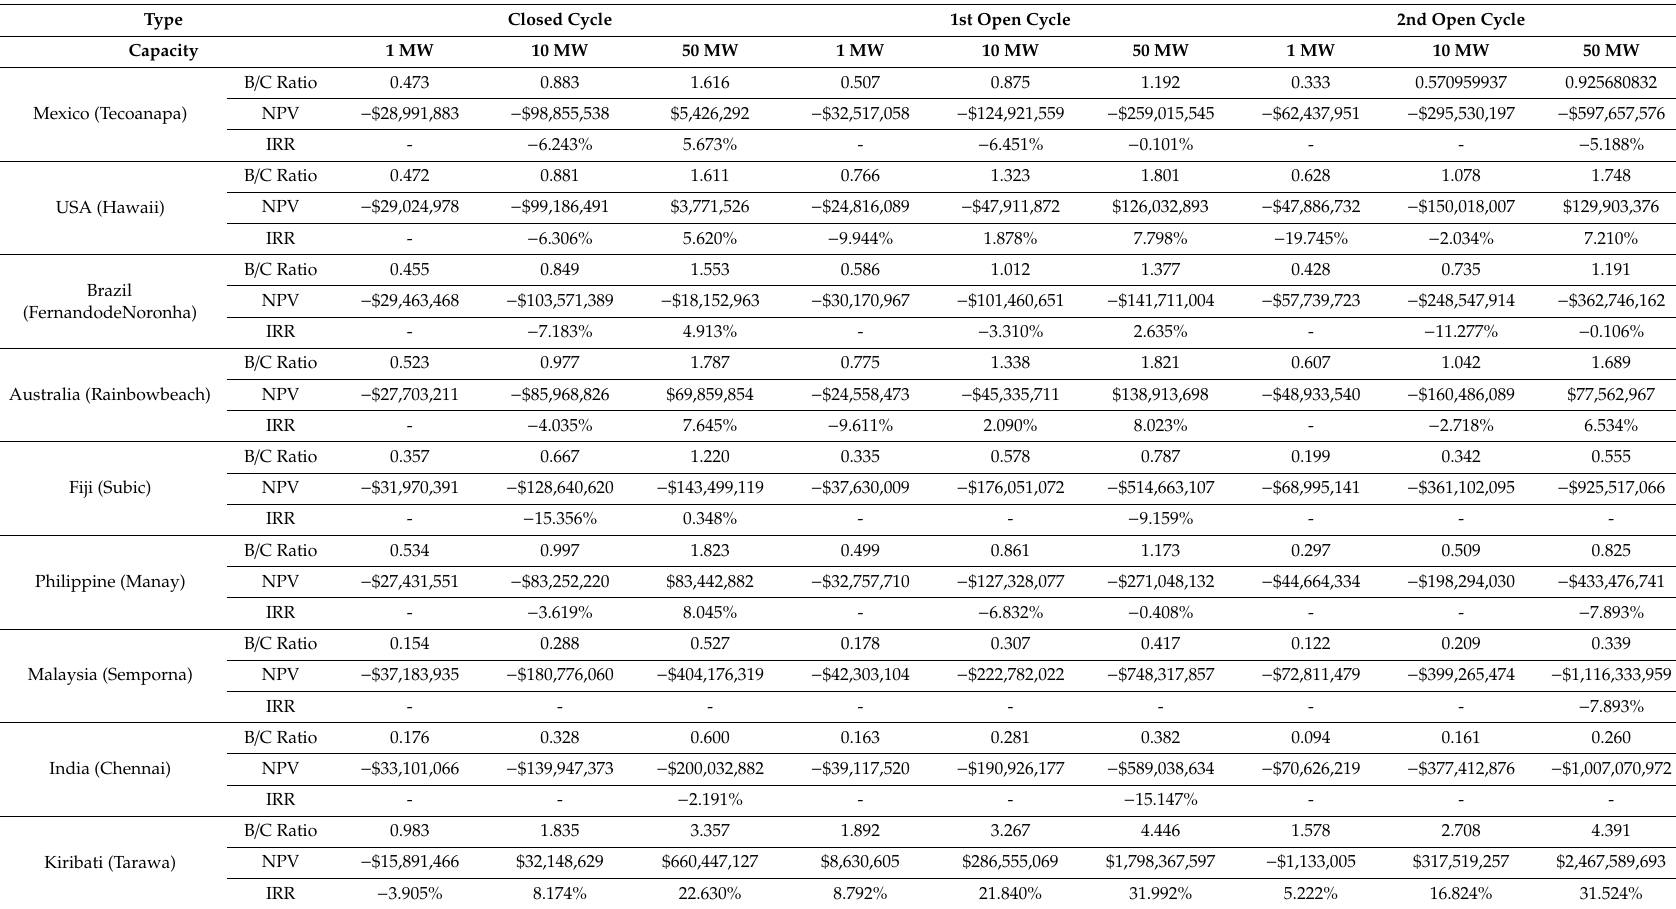
Table 5. Economic analysis according to OTEC’s capacity with 15% increase in initial investment